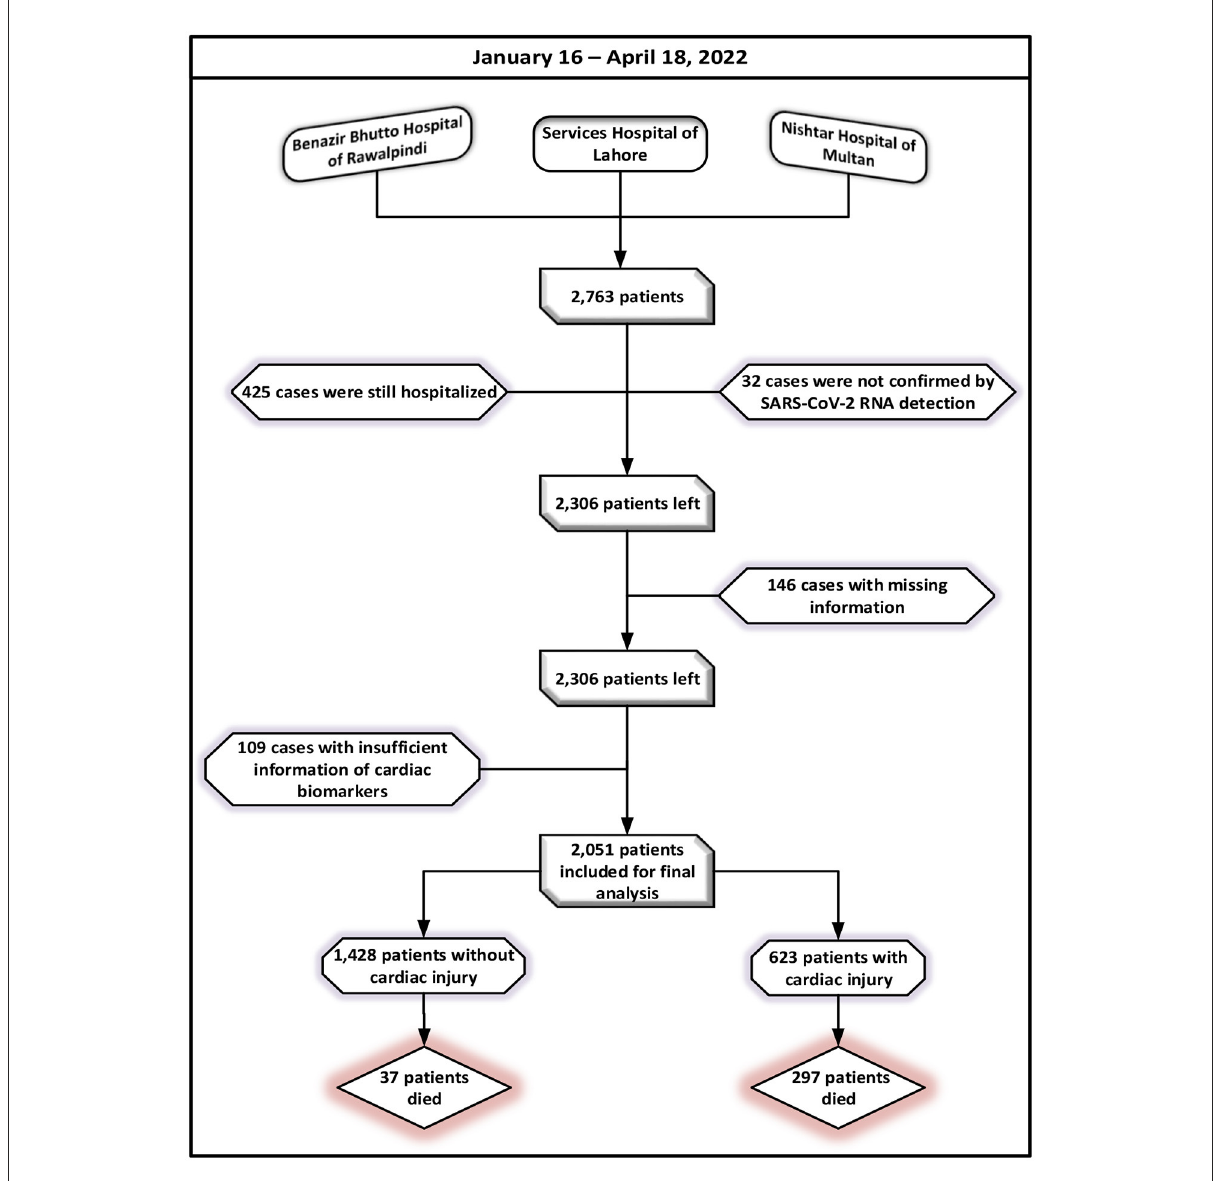
FIGURE1 Patient recruitment